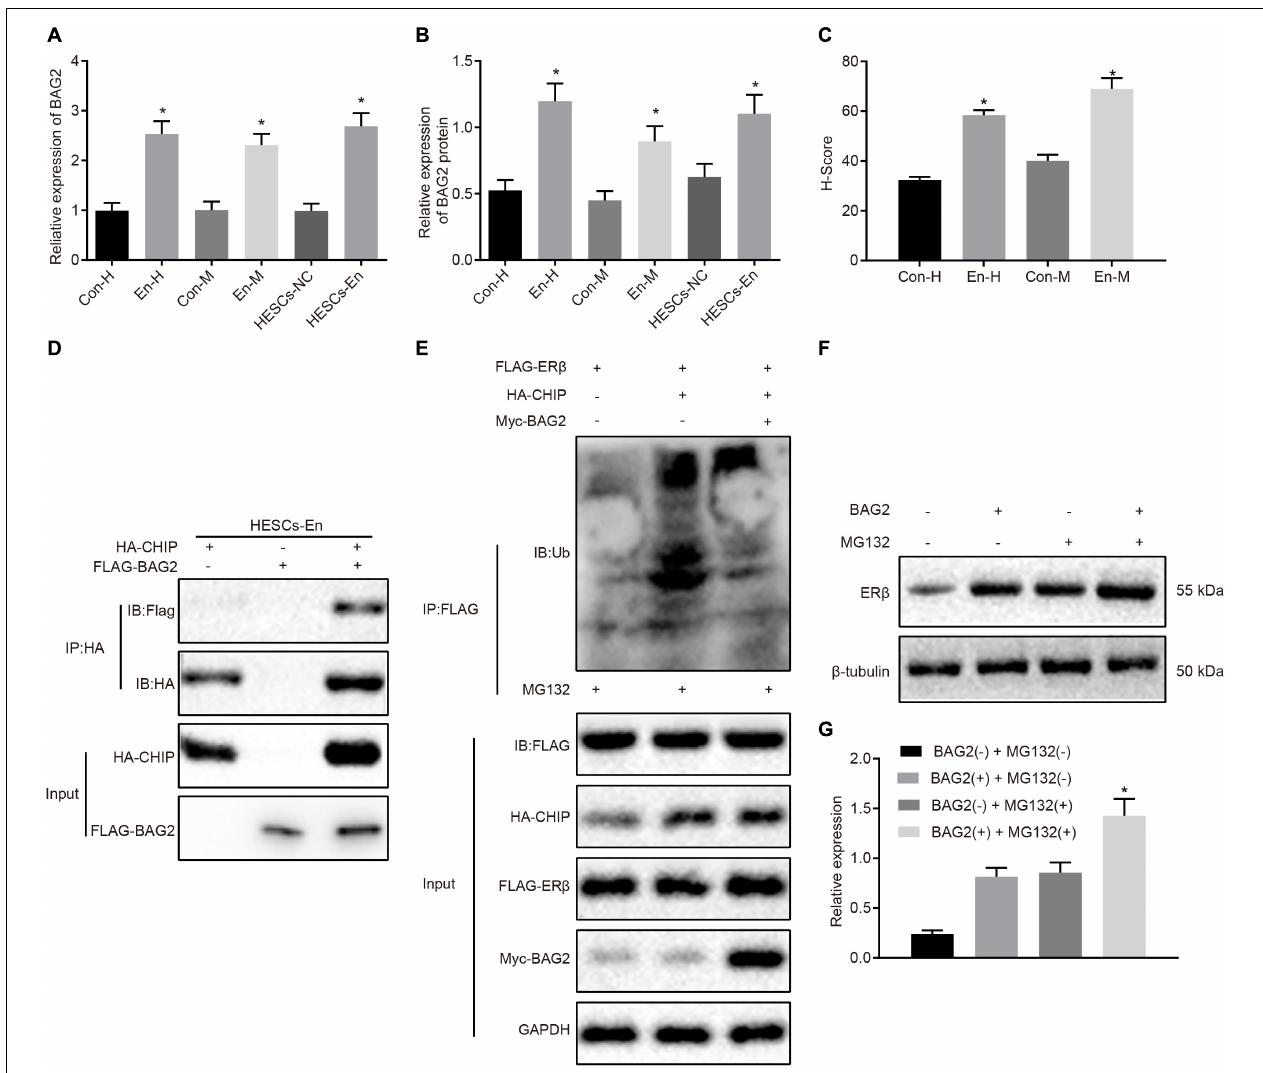
FIGURE 4 | BAG2 inhibits CHIP-mediated degradation of ER β in HESCs in vitro . (A) The mRNA expression of BAG2 in human and mouse endometriosis/normal tissues and HESCs determined by RT-qPCR. (B) The protein expression of BAG2 in human and mouse endometriosis/normal tissues and HESCs determined by Western blot analysis. (C) The statistical analysis of immunohistochemical staining of BAG2 in human and mouse endometriosis/normal tissues. (D) The interaction between CHIP and BAG2 by Co-IP assay. (E) Ubiquitin of ER β in the presence or absence of BAG2 by ubiquitin test. (F) The protein expression of ER β in the presence or absence of BAG2 by Western blot analysis. (G) The statistical analysis of panel (F) . Comparisons between two groups were analyzed using independent sample t -test. * p < 0.05 vs. human or mouse normal tissues, HESCs-NC cells or the absence of BAG2. n = 78 for human normal tissues; n = 91 for human endometriosis tissues; n = 14 for mouse endometriosis/normal tissues. Cell experiments were conducted in